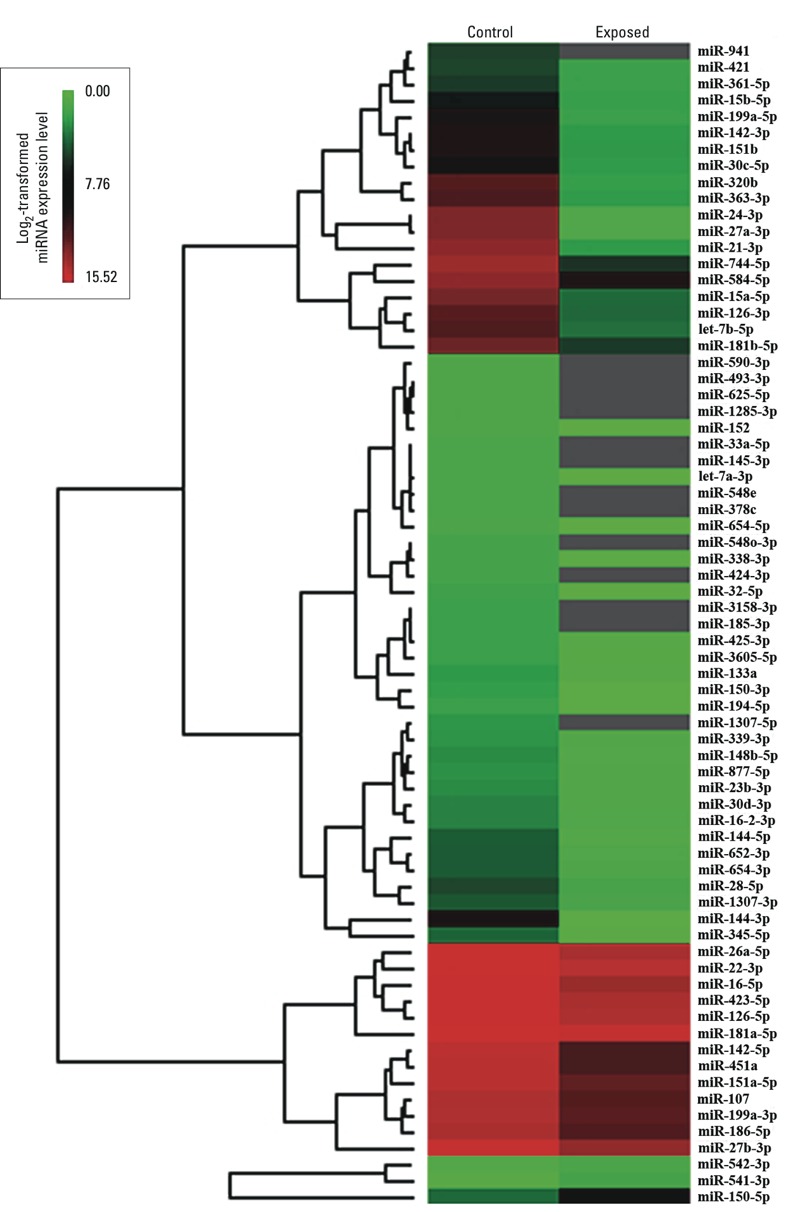
Heat map of the log2-transformed expression levels of 68 miRNAs significantly down-regulated (FC ≤ –5) in the exposed group compared with the controls, and 3 miRNAs (miR-542-3p, miR-541-3p, and miR-150-5p) mildly up‑regulated (+2 ≤ FC < +5) in the exposed group compared with the controls. Gray indicates no detection.